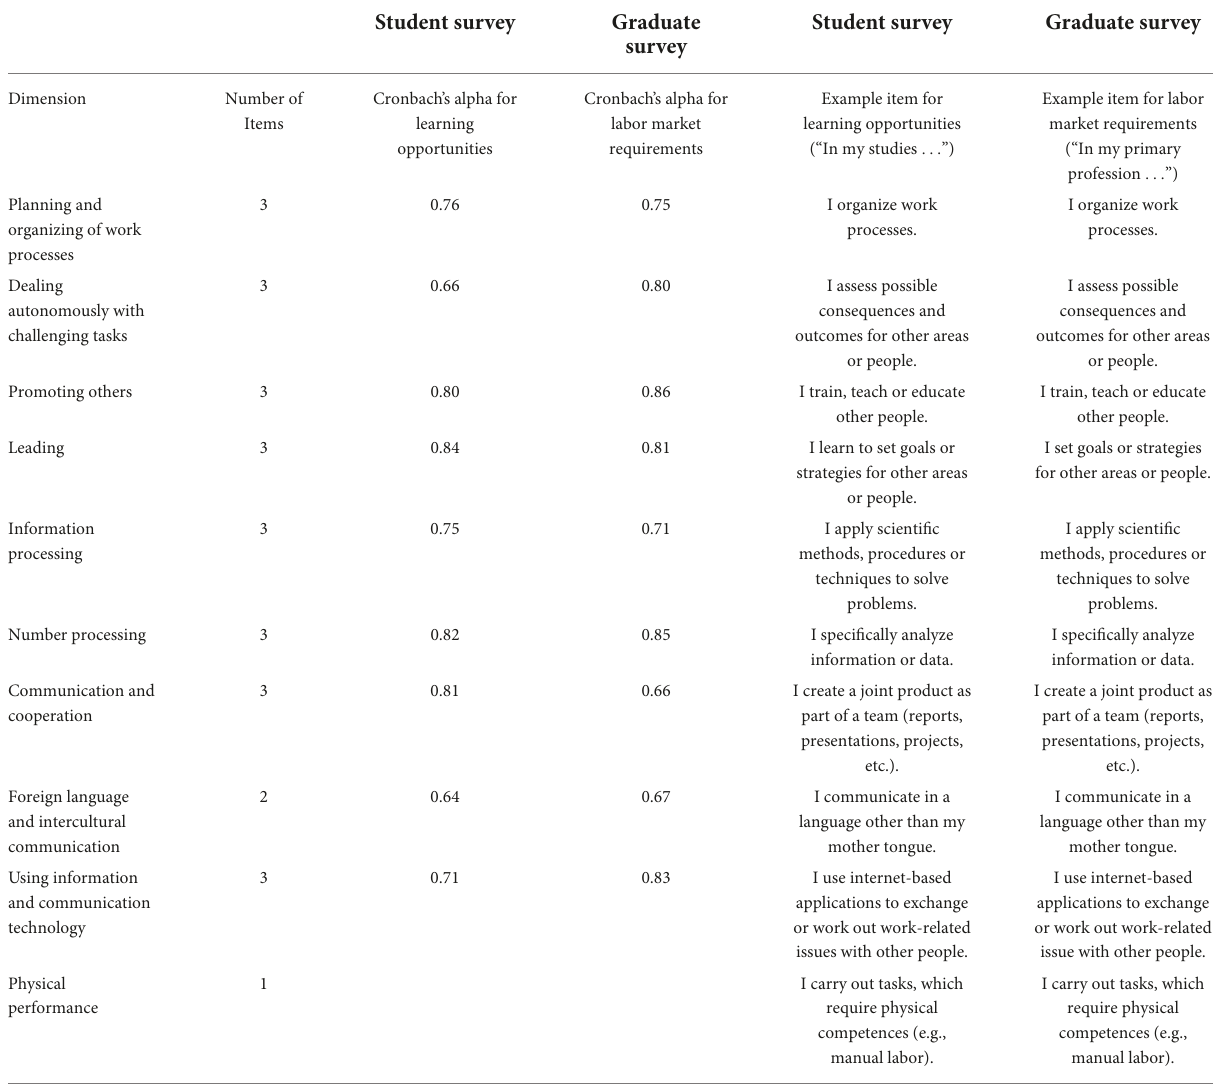
TABLE 2 Dimensions for learning opportunities and labor market